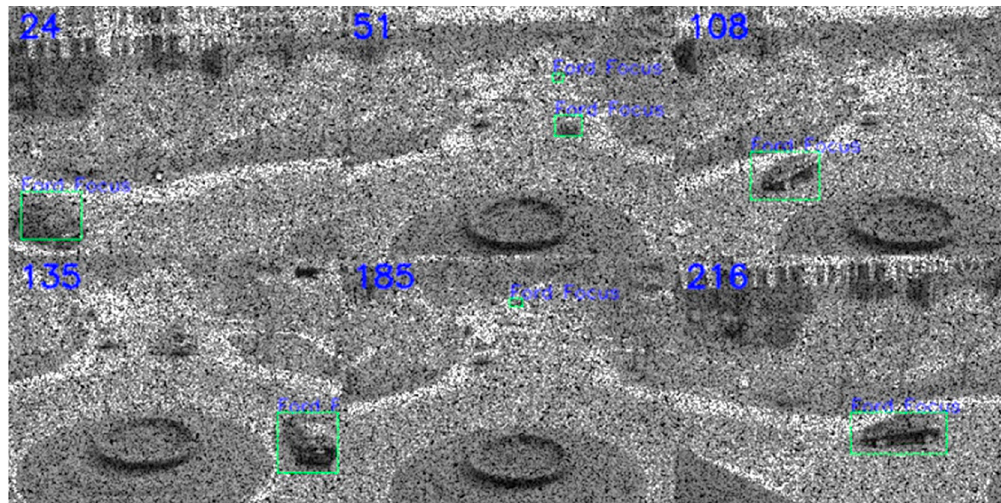
Figure 9. JHU Balcony 50 percent missing tiled image results. Bounding box detections outlined in green. The vehicle is Ford Focus.